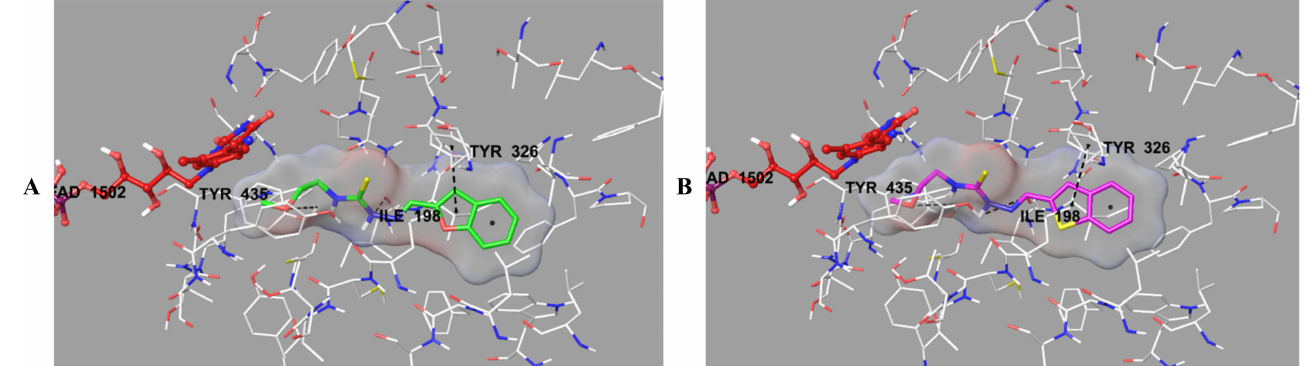
Figure 7. The three-dimensional interacting modes of compounds 2b ( A ) and 2h ( B ) in the active region of h MAO-B. The inhibitors and the important residues in the active site of the enzyme are presented by tube model. The FAD molecule is colored red with ball-stick model.